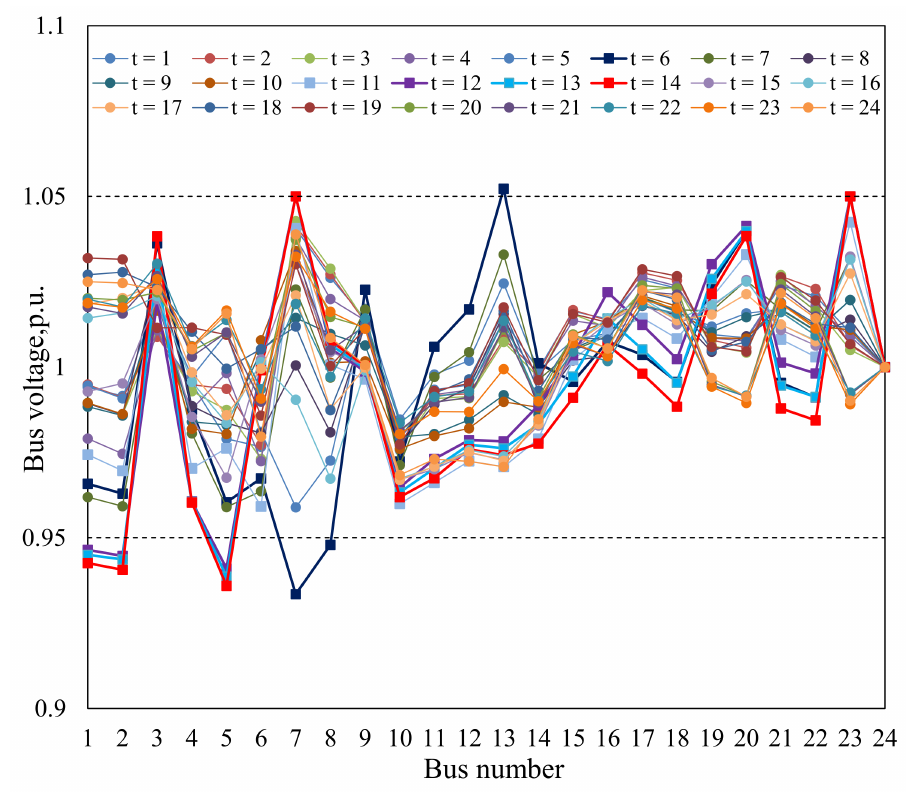
Figure 7. First iteration bus